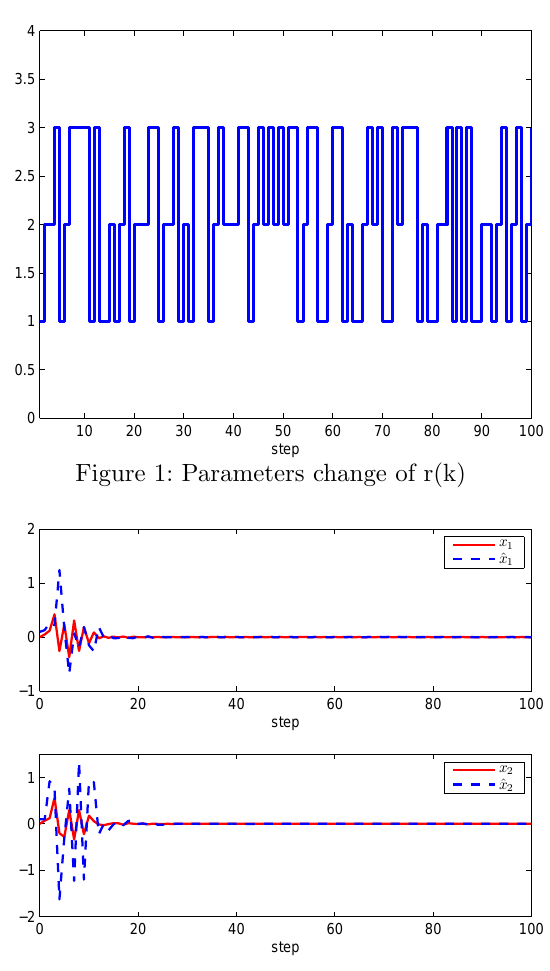
Figure 2: The system state x ( k ) and the filtering state ˆ x .